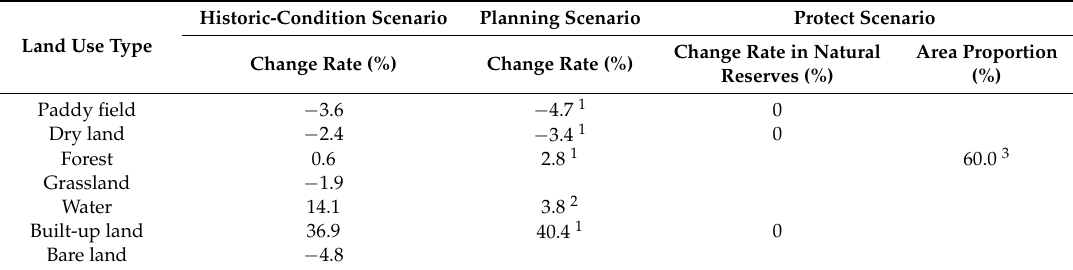
Table 2. Target of land use conversion from 2015 to 2030 under different